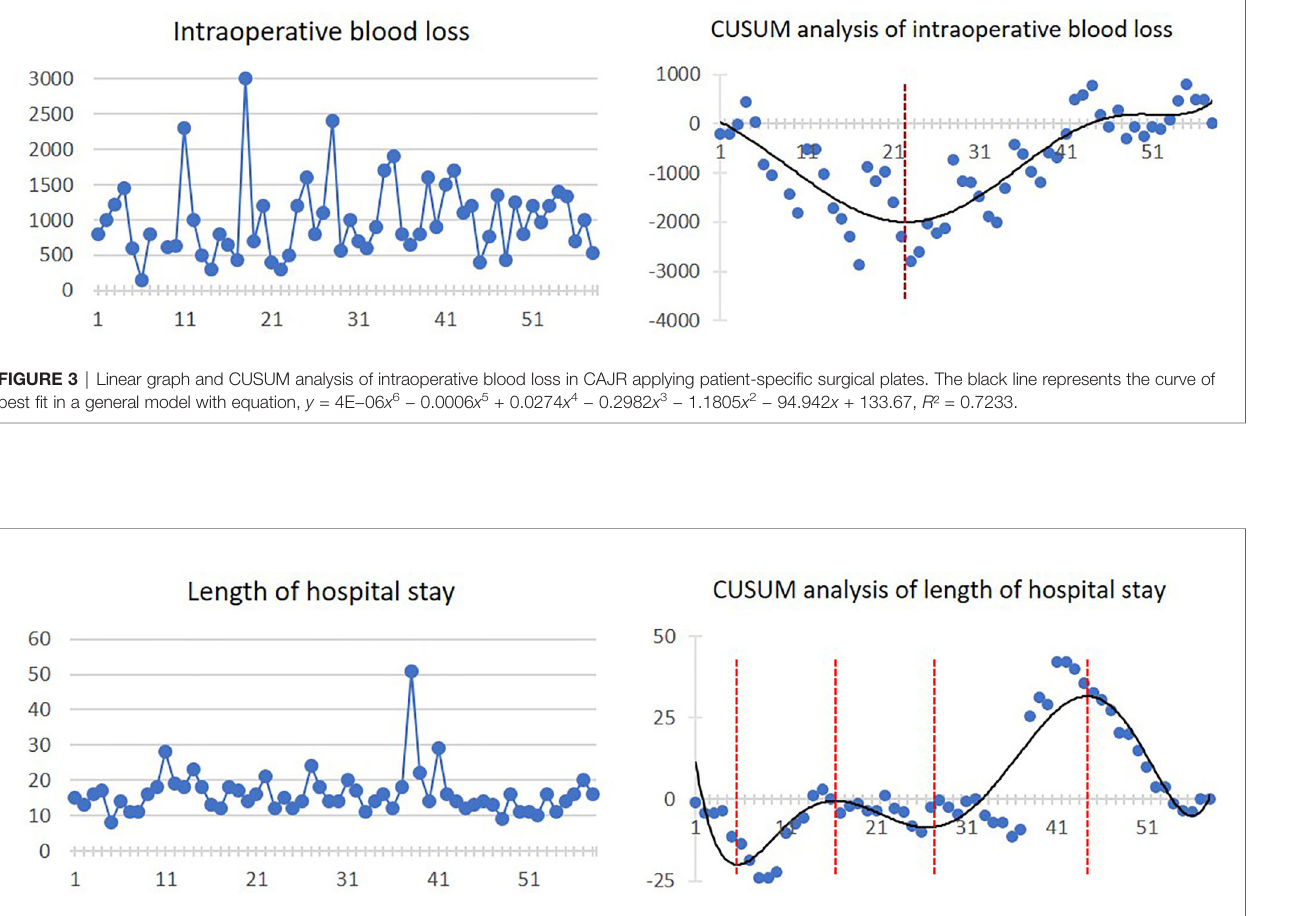
FIGURE 4 | Linear graph and CUSUM analysis of hospital stay length in CAJR applying patient-speci fi c surgical plates. The black line represents the curve of best fi t in a general model with equation, y = 6E − 07 x 6 − 0.0001 x 5 + 0.0077 x 4 − 0.2461 x 3 + 3.7349 x 2 − 23.636 x + 31.376, R ² =